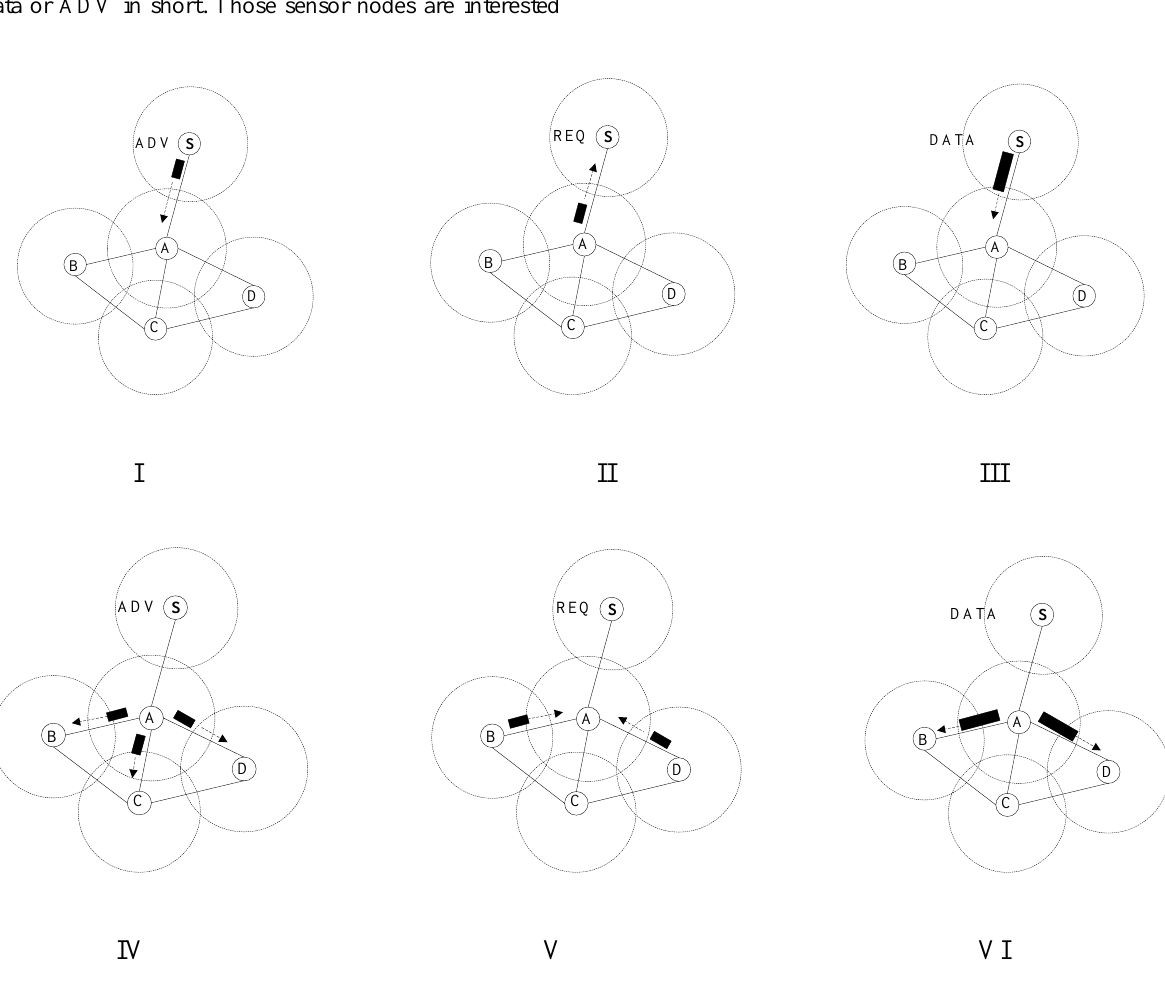
Figure 4 . SPIN protocol. Node S begins the advertising its meta-data to node A (I). Node A is requesting the complete data in response of meta-data (II). Actual data is transferred from node S to node A (III). Similar process continues as advertisement of meta-data by node A to their neighbors (B, C & D) in (IV), requesting complete data by only node B & node D (V), and actual data transfer in response of request to node B & node